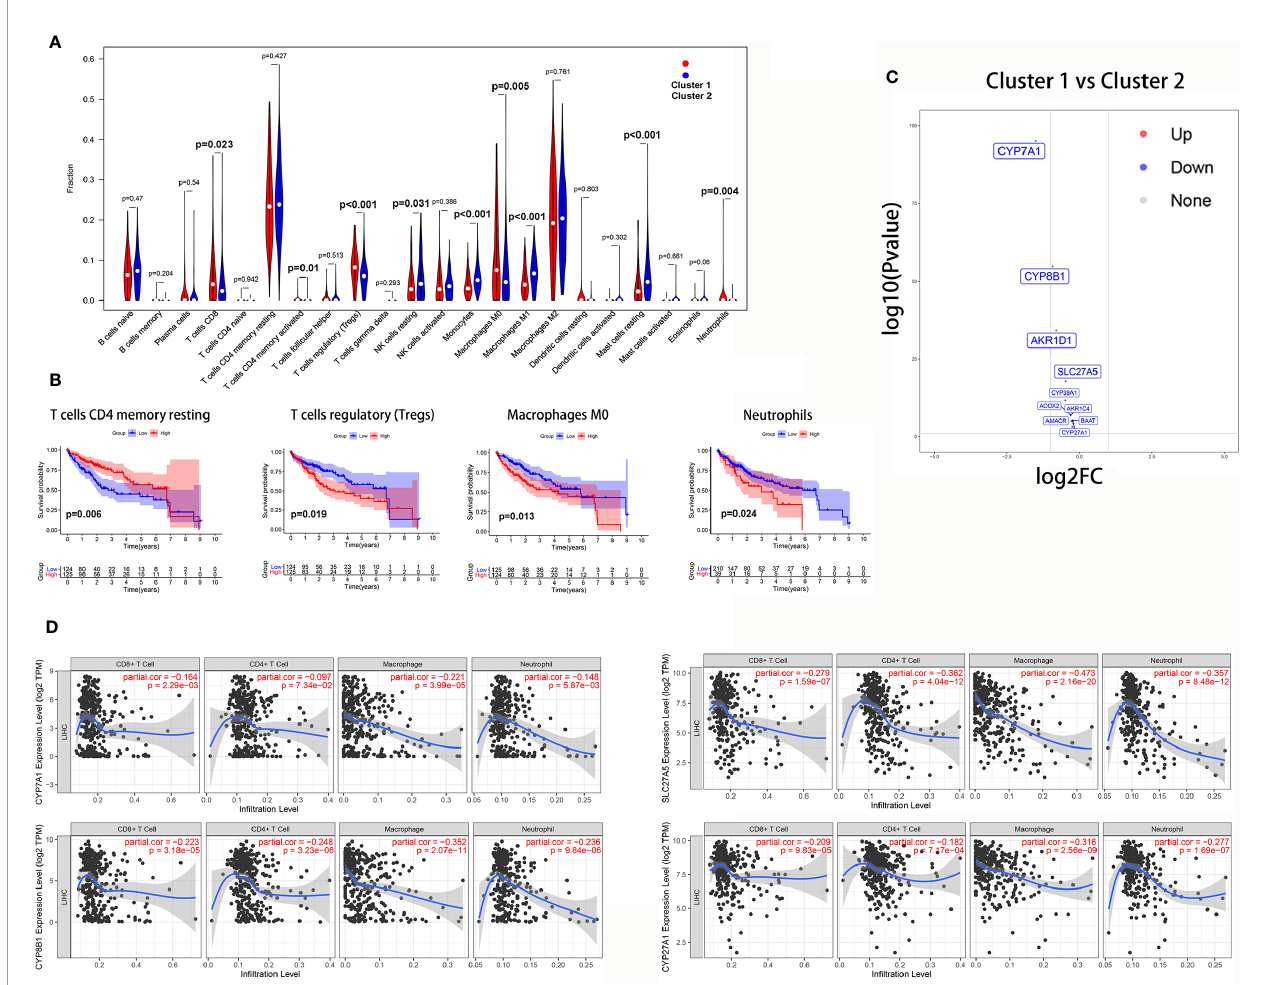
FIGURE 9 | The correlation between the bile acid biosynthesis pathway and immune cell in fi ltration of tumors. (A) The comparison of the fractions of immune cells between the cluster 1 and cluster 2 HCC samples. (B) Kaplan-Meier survival analysis of overall survival between high and low levels of in fi ltrating immune cells. (C) Volcano plot of all genes in the primary bile acid biosynthesis between cluster 1 and cluster 2. (D) The correlation between gene expression and immune cell in fi ltration of